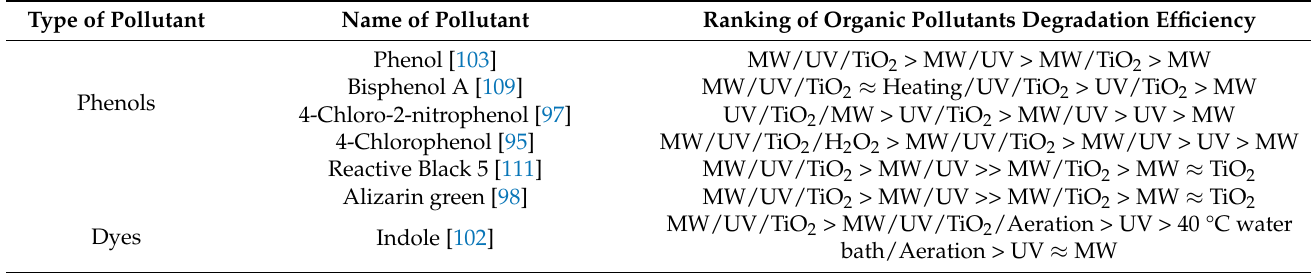
Table 2. Ranking of organic pollutants degradation efficiency under different conditions 1